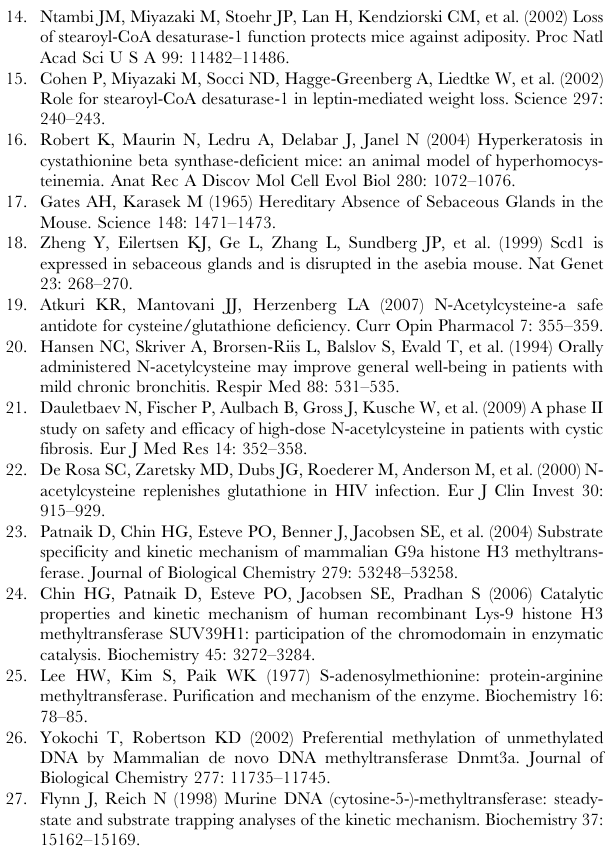
Figure S1 Effect of NAC treatment on hair loss pheno- type. Representative pairs of sibling of Tg-I278T Cbs 2 / 2 and Tg- I278T Cbs + / 2 mice are shown over the course of 60 to 240 days of age. Panels on left show pair on regular water, while panels on right shows a different pair on NAC water. Figure S2 Effect of NAC treatment on water and food consumption in Tg-I278T Cbs + / 2 control mice. (A) Water consuminption is shown for a six week period with the mean 6 SD from each cage shown. (B) Food consumption is shown. (C) Total weight gained and total food consumed by NAC treated control